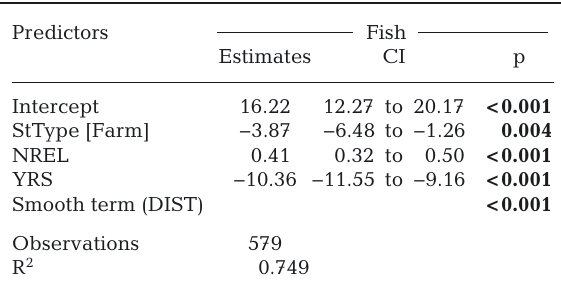
Table 2. Determinants of the number of cod observed at a given station during the spawning period. Given predictors are the parametric explanatory variables Station Type (StType; categorical variable), number of fish released at a given distance from the station (NREL; continuous variable) and years since release (YSR; continuous variable). The treat- ment contrast of R was used with the intercept value repre- senting the value for a spawning ground station. Square brackets indicate a categorical variable tested against the reference values. For these parametric explanatory vari- ables, Estimate is the parameter estimate, CI is the 95% con- fidence interval and p is the p-value for the predictors. For the smooth term, estimates is the estimated degrees of free- dom (edf). Significance ( bold ) was assigned at p < 0.05. Only